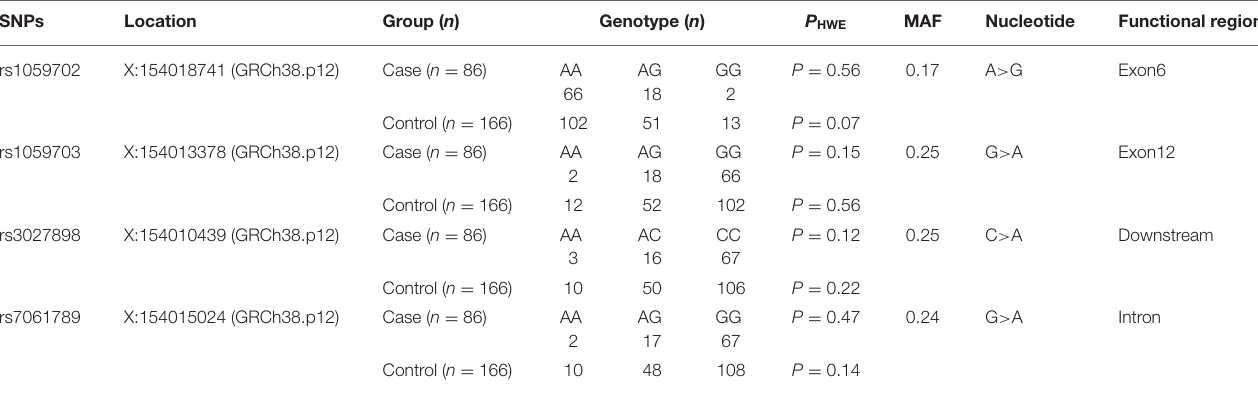
TABLE 4 | Selected SNPs of IRAK1 in this